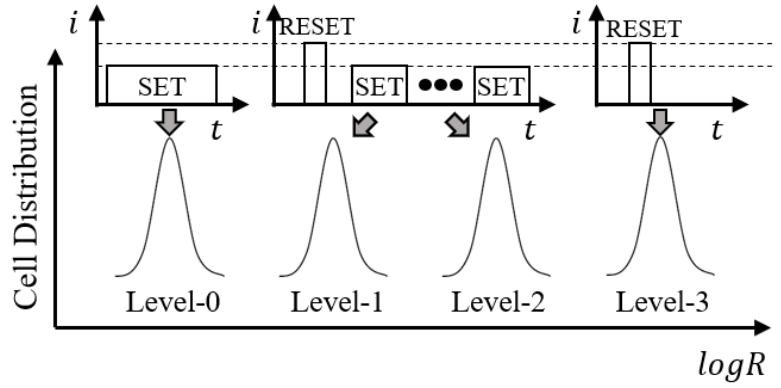
Figure 1. Iterative write operations in 4LC PCM.